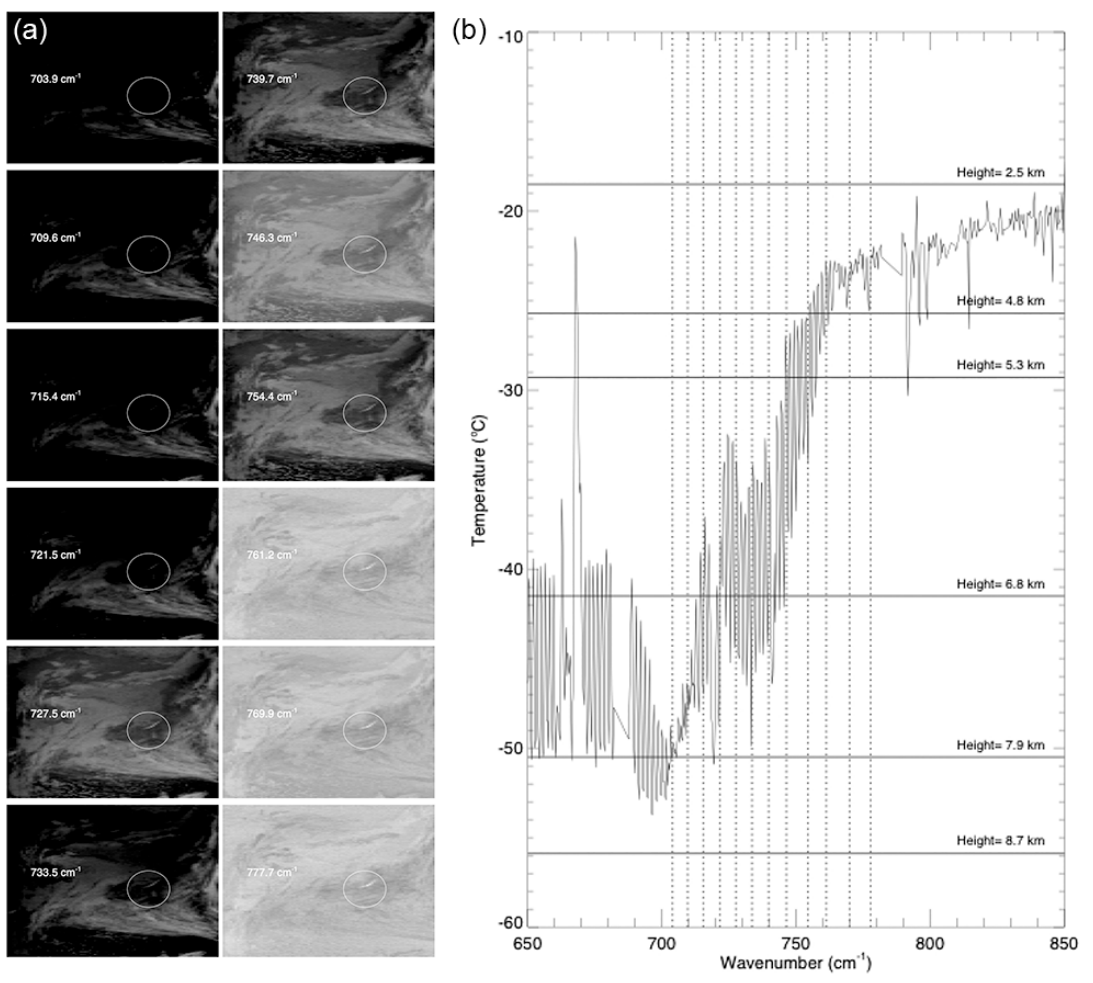
Figure 21. ( a ) Sequence of satellite images showing a small volcanic plume in different channels from the AIRS instrument measured at different infrared wavenumbers (values shown on each panel) all at the same time. Each image was individually histogram stretched to increase the contrast. ( b ) Temperature at the centre of the plume plotted against wavenumber for the same satellite image. The dashed lines correspond to the wavenumbers of the images shown in ( a ).